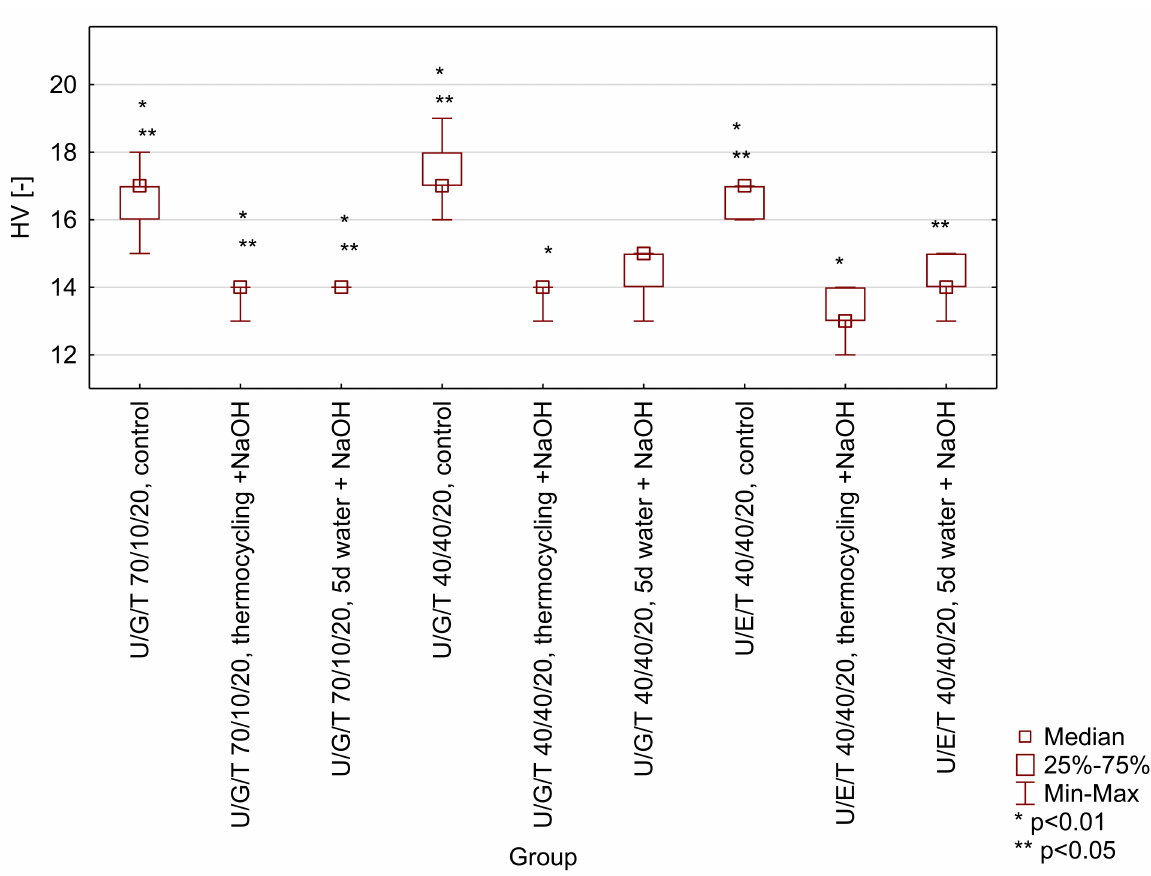
Figure A3. Box-and-whisker plot of Vickers hardness (HV) of tested matrices (UDMA/Bis- GMA/TEGDMA 70/10/20 wt.% and 40/40/20 wt.% and UDMA/Bis-EMA/TEGDMA 40/40/20 wt.%) after selected ageing protocols (control-water, 24 h, 37 ◦ C; thermocycling + NaOH- water, 7500 thermo cycles, 5/55 ◦ C and 0.1 M NaOH, 7 days, 60 ◦ C; 5 d water + NaOH-water, 5 days, 55 ◦ C and 0.1 M NaOH, 7 days). Significant differences occur in a given group with a probability of p < 0.01 (*) and/or p < 0.05 (**). Table A2. Probabilities for multiple comparison testing for Vickers hardness (HV) of tested matrices.